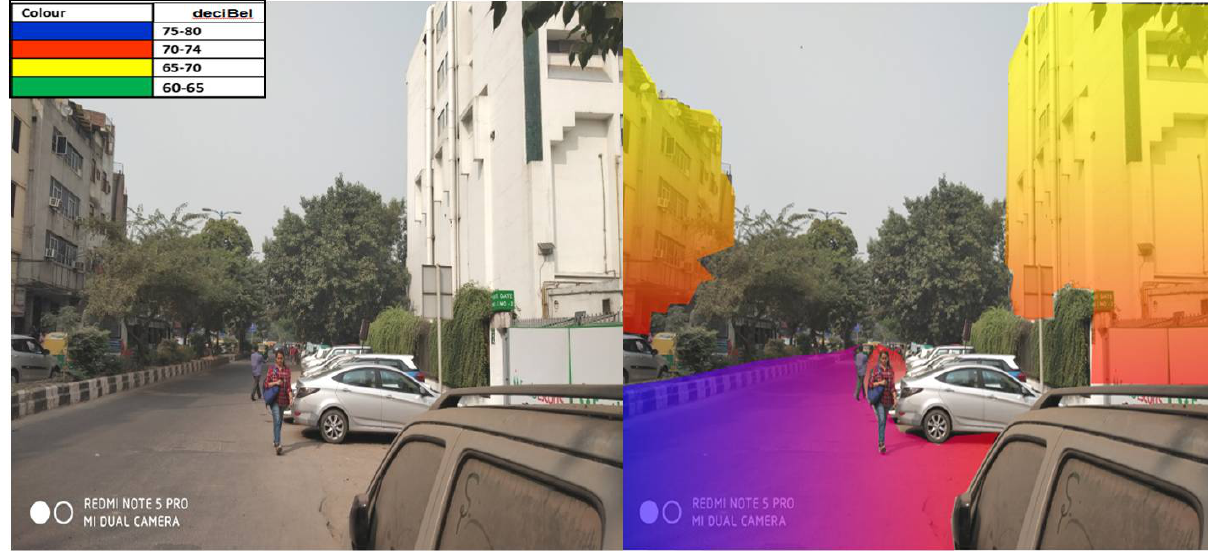
Figure 12: 3D noise mapping of Sukhdev Vihar before installation of noise barrier